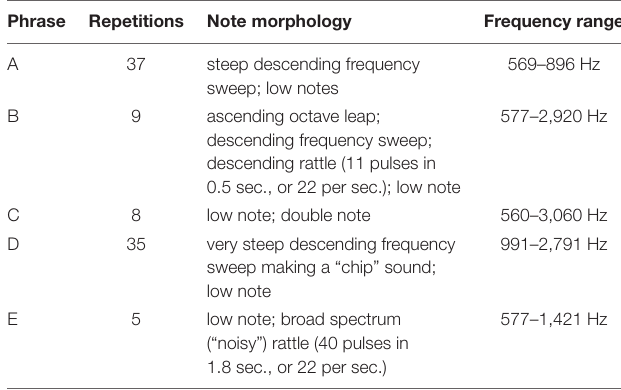
TABLE 1 | A summary of the adult bird’s phrases, delivered in Supplementary Audio 2 from 12:59 to 38:58 = 25 (cid:48) 59 (cid:48)(cid:48) total. Phrase Repetitions Note